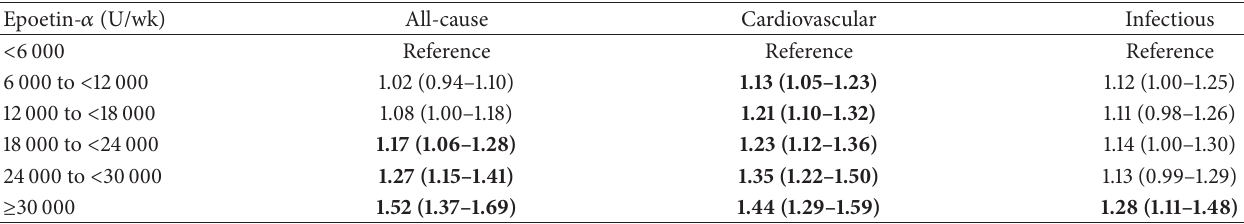
Table 3: Adjusted odds ratios (95% confidence interval) for mortality by weekly epoetin- 𝛼 doses in overall patient